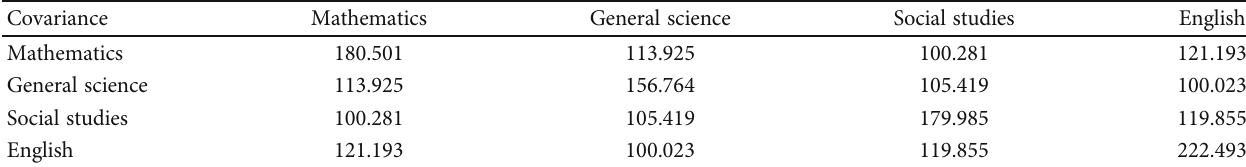
Table 14: The covariance for total tribal girl students.